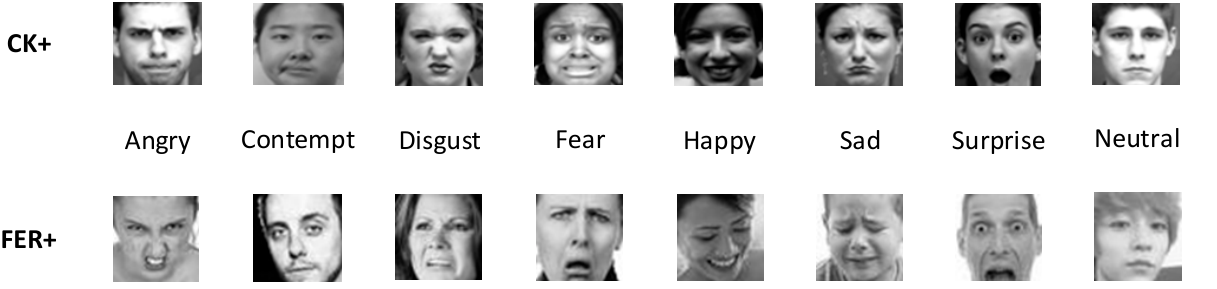
Figure 6. Some examples of the dataset used in the experiment. The first row of images is from CK+, and the second row is from FERPLUS, which has eight emotions (anger, contempt, disgust, fear, happiness, sadness, surprise, and neutrality), with the new emotion label of contempt added to FERPLUS.